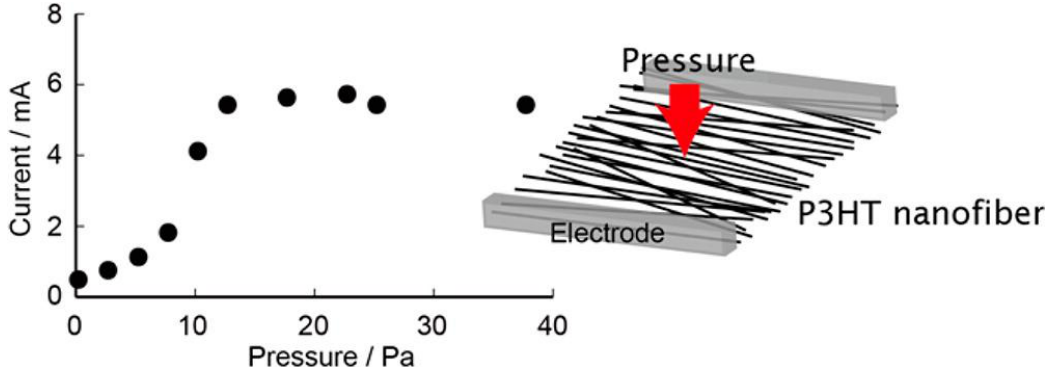
Figure 16. Schematic of the arrangement of the electrodes on the P3HT nanofiber assembly in the tactile sensor and current changes from P3HT nanofiber assemblies as a function of applied pressure. Reprinted with permission from [169]. Copyright (2012) by American Chemical